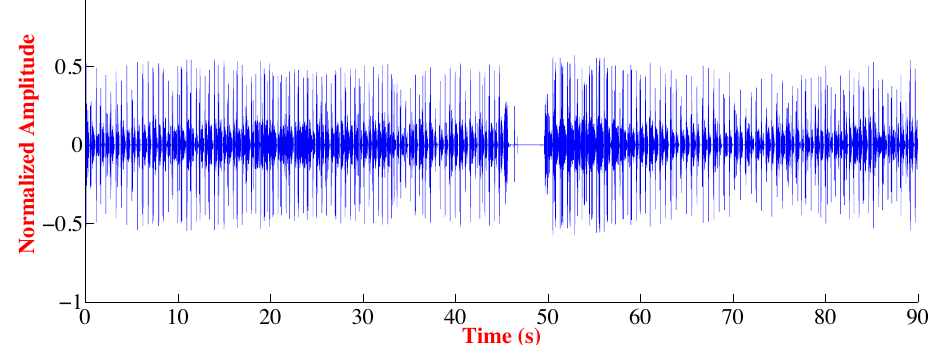
Figure 1. Empirical mode decomposition (EMD) of a real-world Doppler ultrasound (DU) signal obtained with S = 3 and n = 2.